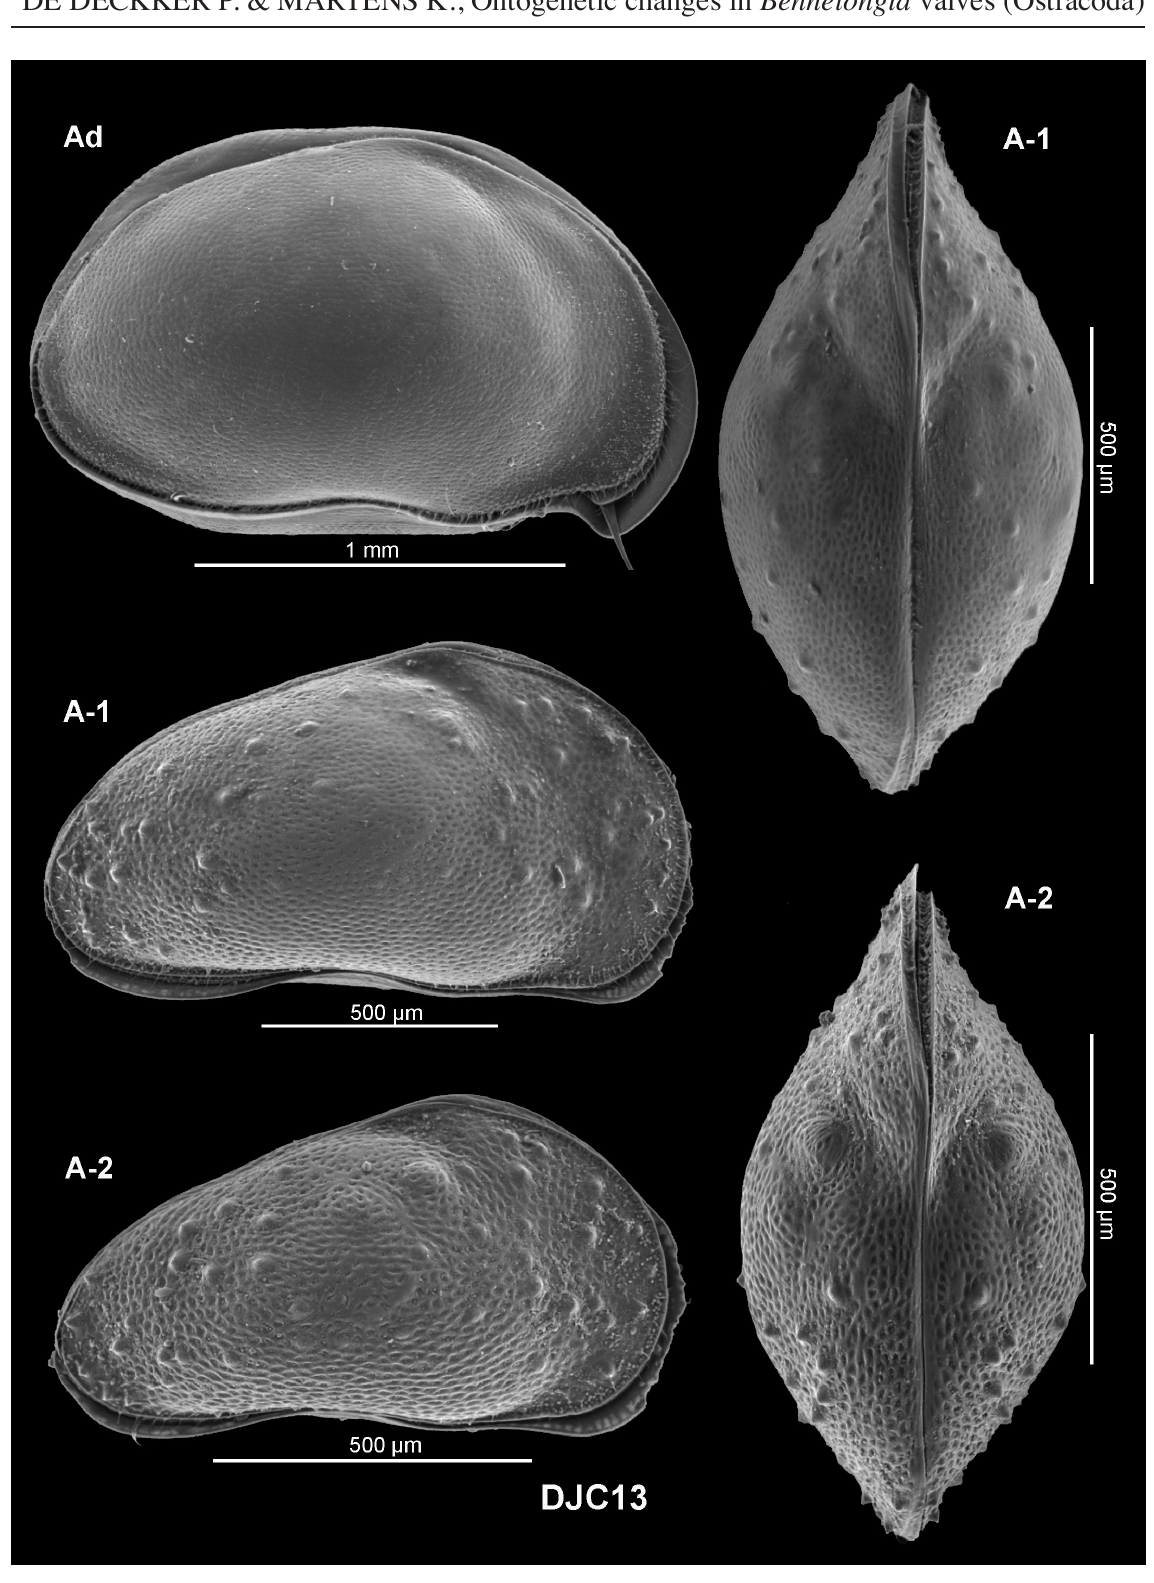
Fig. 22. External views of carapaces of Bennelongia gwelupensis Martens et al ., 2012 from Arro Swamp. Right lateral views in left column for adult, A-1 and A-2 specimens, and dorsal views on the right of A-1 and A-2 specimens. Note that the ornamentation becomes progressively more intricate at younger